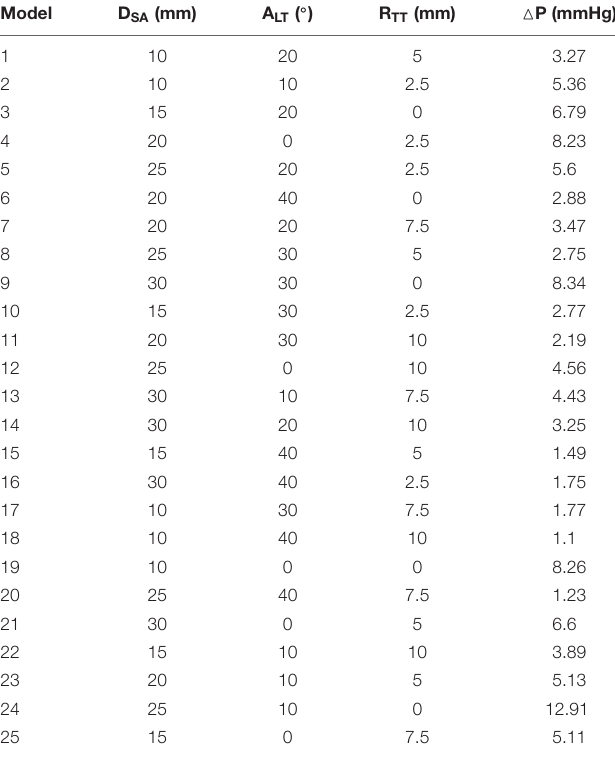
TABLE 1 | Orthogonal test design table and